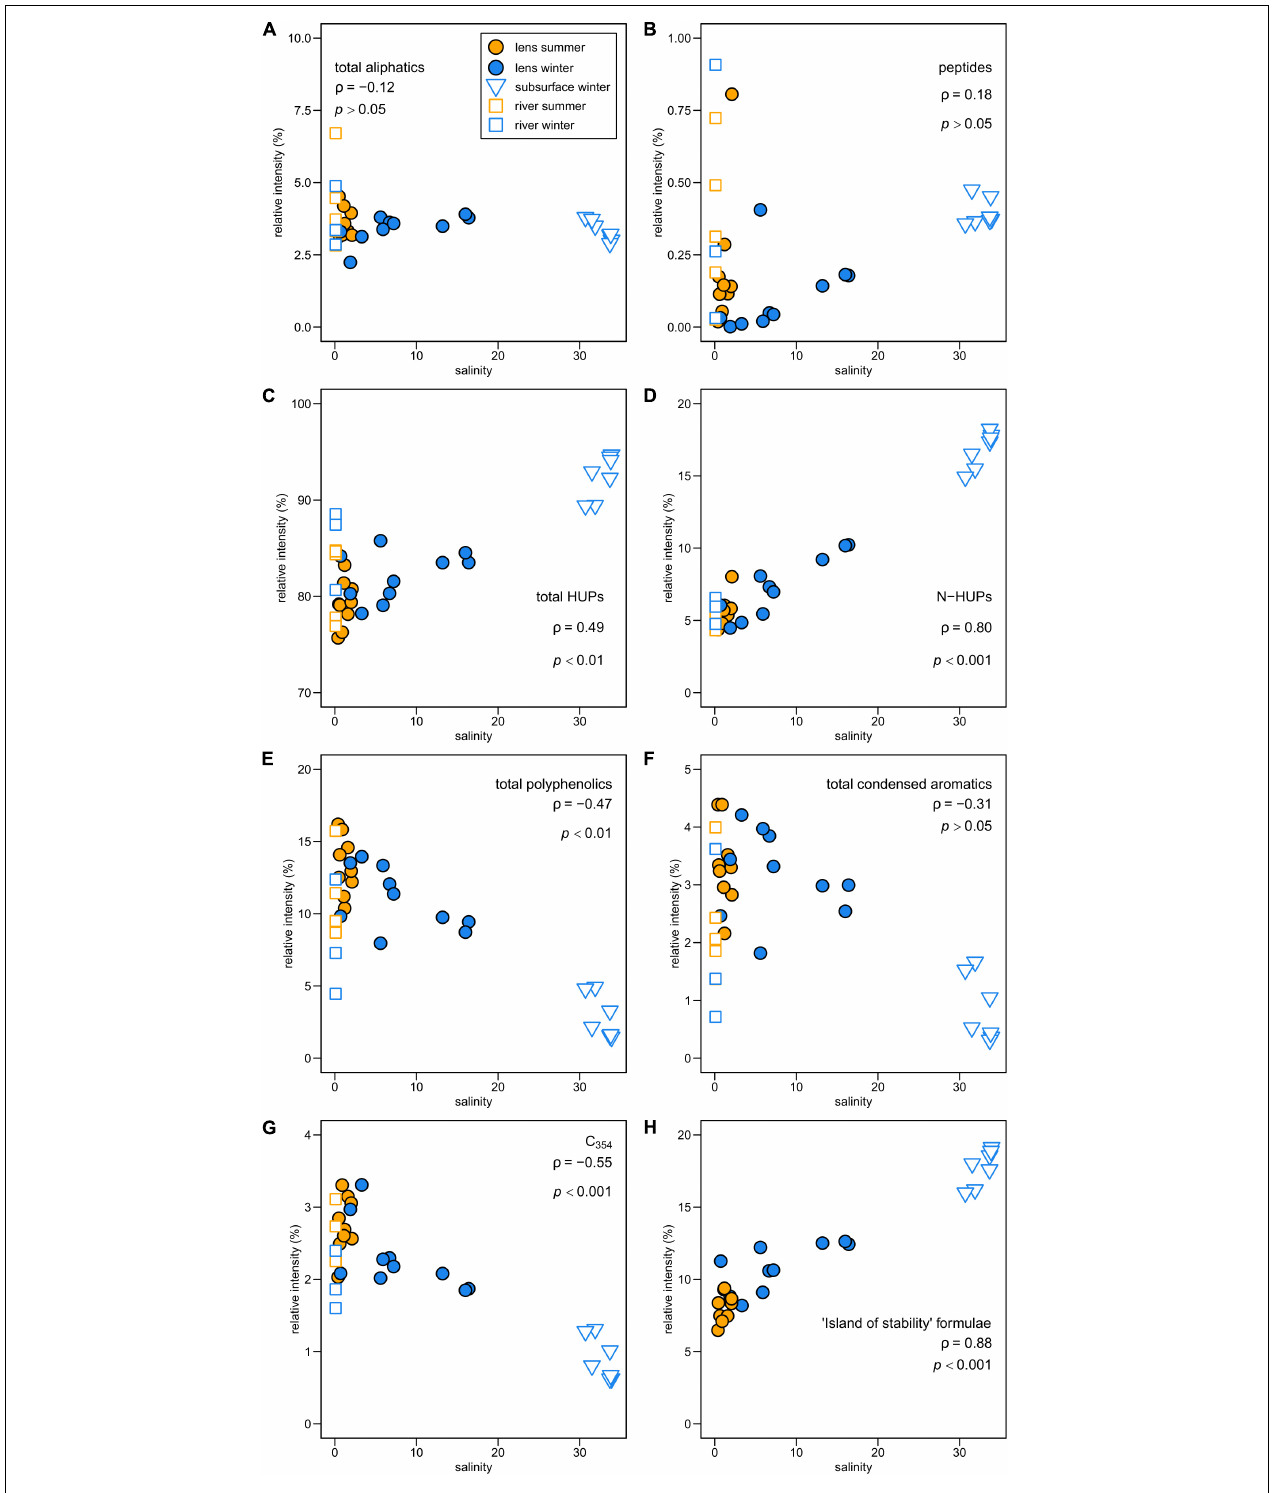
FIGURE 4 | Relationship between FT-ICR MS compound category relative intensities and salinity in Baker-Martinez Fjord for (A) aliphatic, (B) peptide-like, (C) all HUPs, (D) N-HUPs, (E) polyphenolic and (F) condensed aromatic formulae. Sub-panel (G) shows variations in formulae correlated with tryptophan-like (C 354 ) fluorescence in river samples across the broader region; and (H) shows variations in formulae from a stable pool of marine DOM, termed the “island of stability” (Lechtenfeld et al., 2014). Sub-panels annotated with non-parametric correlation coefficient (Spearman’s ρ ) and p -value where p > 0.05 is not deemed significant. River samples excluded from correlations but shown for